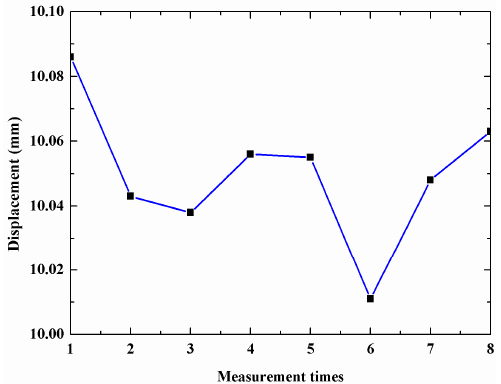
Figure 5. Measurement stability of the sensor.